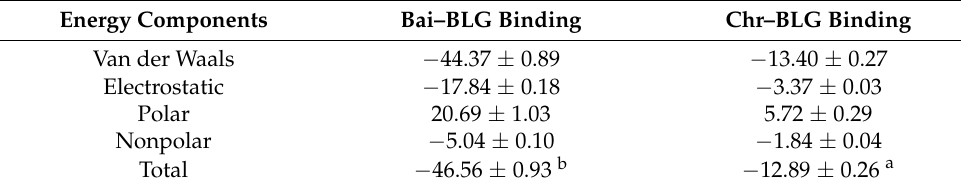
Table 4. Summary of free energy decomposition (kJ mol − 1